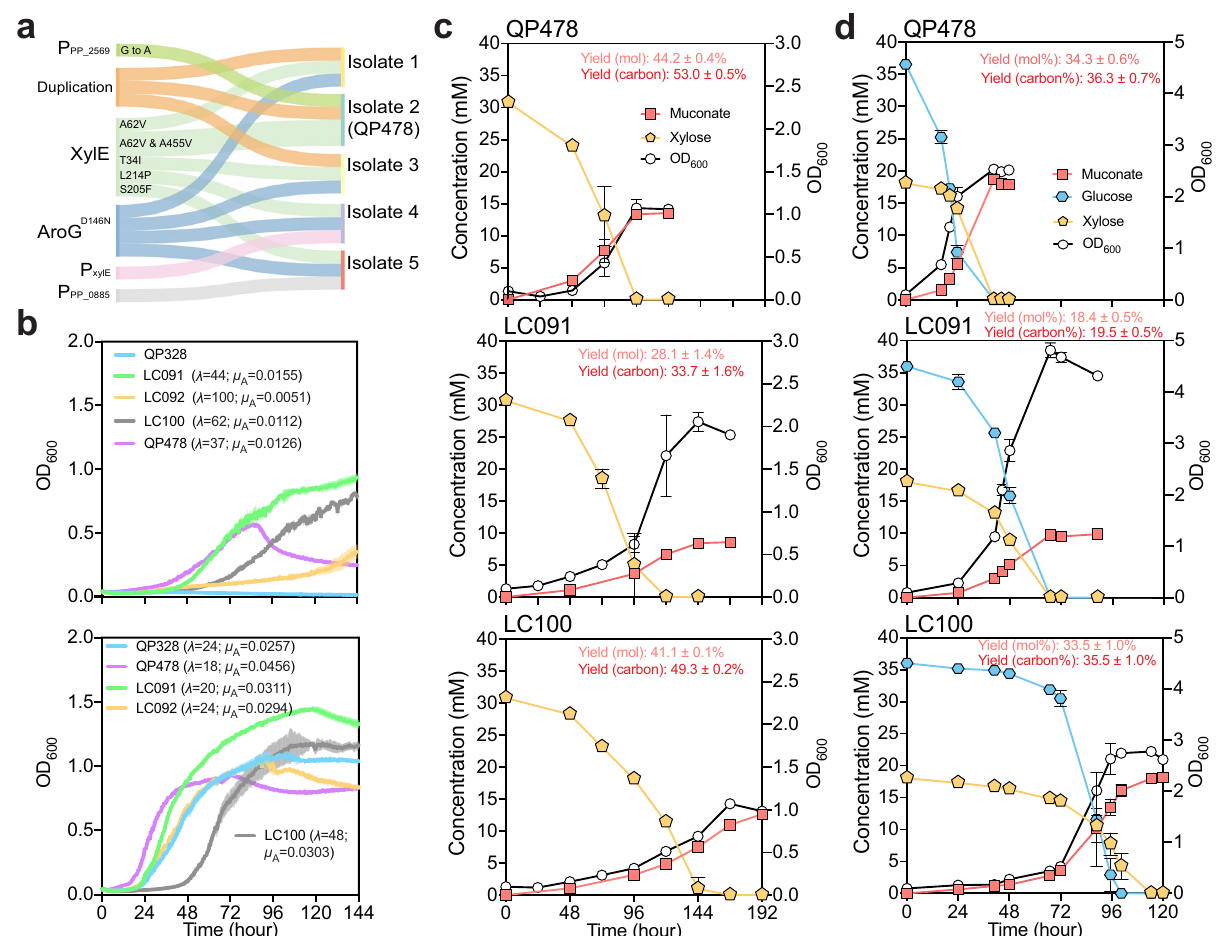
Fig. 2 | Evaluation of reverse engineered strains comparing to QP478. a Mutations identi fi ed in ALE by whole-genome sequencing of the fi ve isolates (theSankeydiagramwasbuiltusingSankeyMATIConlinetool). b Growthcurveof reverse engineered strains LC091 and LC100, with the unevolved strain QP328 andtheevolvedstrainQP478forcomparison. μ A representsabsolutegrowthrate, and all μ A presented here are the average values of three independent growth curves. c Shake- fl askexperimentsofreverseengineeredstrainsLC091andLC100, comparing to QP478, on M9 medium supplemented with 30mM xylose. Yield of